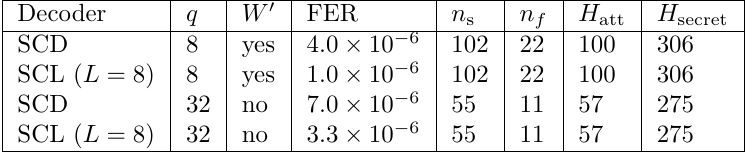
Table 2: Decoding results for T=20° using the q -ary Polar codes. The number of correctly transmitted symbols is denoted as n s . Of those n s symbols, n f symbols are readable in an attack scenario, while the remaining n s − n f symbols exhibit a high error rate. With that, we estimate the secret length in bits as H secret and the complexity of an attacker to H att